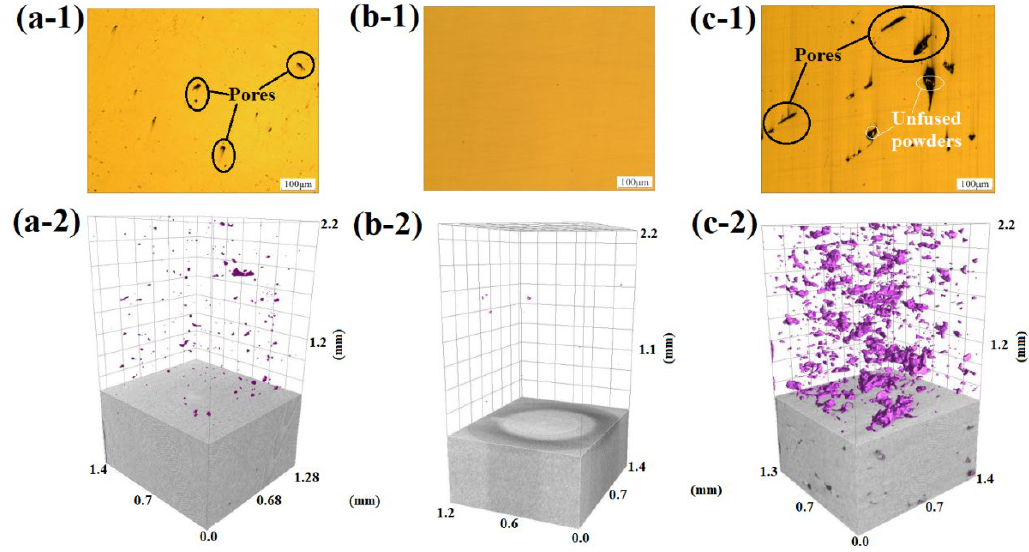
Figure 4. 2-D and 3-D pore distribution plots of different printing parameters: ( a-1, a-2 ) 200 W, 0.09 mm, 800 mm/s; ( b-1, b-2 ) 190 W, 0.09 mm, 800 mm/s; and ( c-1, c-2 ) 170 W, 0.09 mm, 800 mm/s.